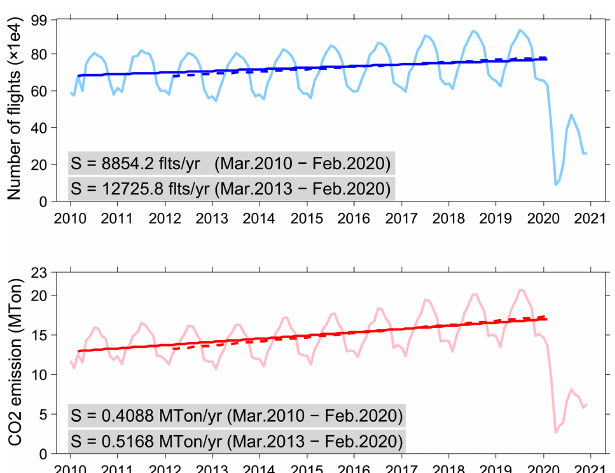
Figure 1. Number of flights and the corresponding CO 2 emis- sions from air traffic in different months over Europe (a total of 42 countries and regions) in 11 years during 2010–2020. The sea- sonal cycle in air traffic shows more flights (as well as CO 2 emis- sions) in summer than in winter. The number of flights increased by about 1.30%yr − 1 , whereas the CO 2 emissions increased by about 3.16%yr − 1 in the last 10 years in Europe before the COVID- 19 outbreak. During the COVID-19 pandemic, however, civil avi- ation in Europe was significantly reduced from March 2020 with only a partial recovery in summer 2020 and further reduction af- terwards. Furthermore, we also note that there was in fact a slight decrease in the first 3 years from 2010 to 2013, especially in winter and early spring. The plots are reproduced based on the European flight historic data from the European Organisation for the Safety of Air Navigation (EUROCONTROL, https://www.eurocontrol.int/ covid19, last access: 9 February